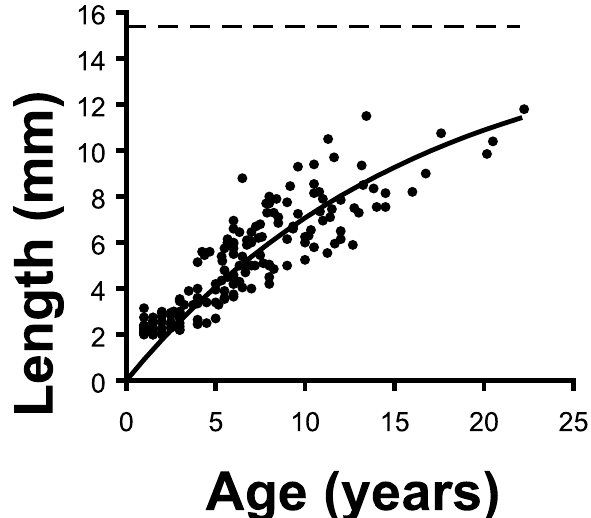
Figure 4. General age-length von Bertalanffy growth curve (see Eq. 1) describing the growth in all populations. Dotted line indicates the maximum expected length of corals in all populations ( L ‘ =15.4 mm). Points indicate the age/size of all samples in all populations dated by CT scans ( n =175) from which the general growth curve was